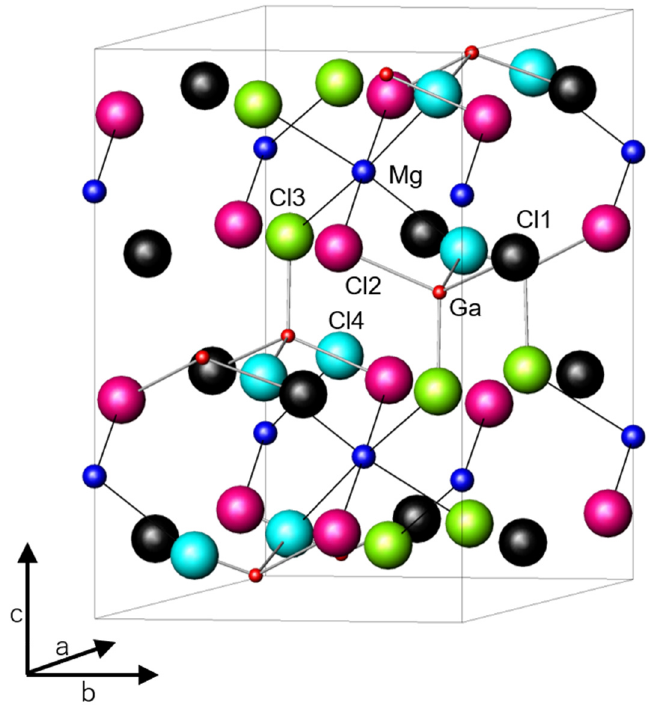
Figure 2. Crystal structure of MgGa 2 Cl 8 obtained by Rietveld analysis of the XRD pattern. Cl1-4 indicate halogen sites. Table 1. Results of the Rietveld analysis of XRD data for MgAl 2-x Ga x Cl 8.